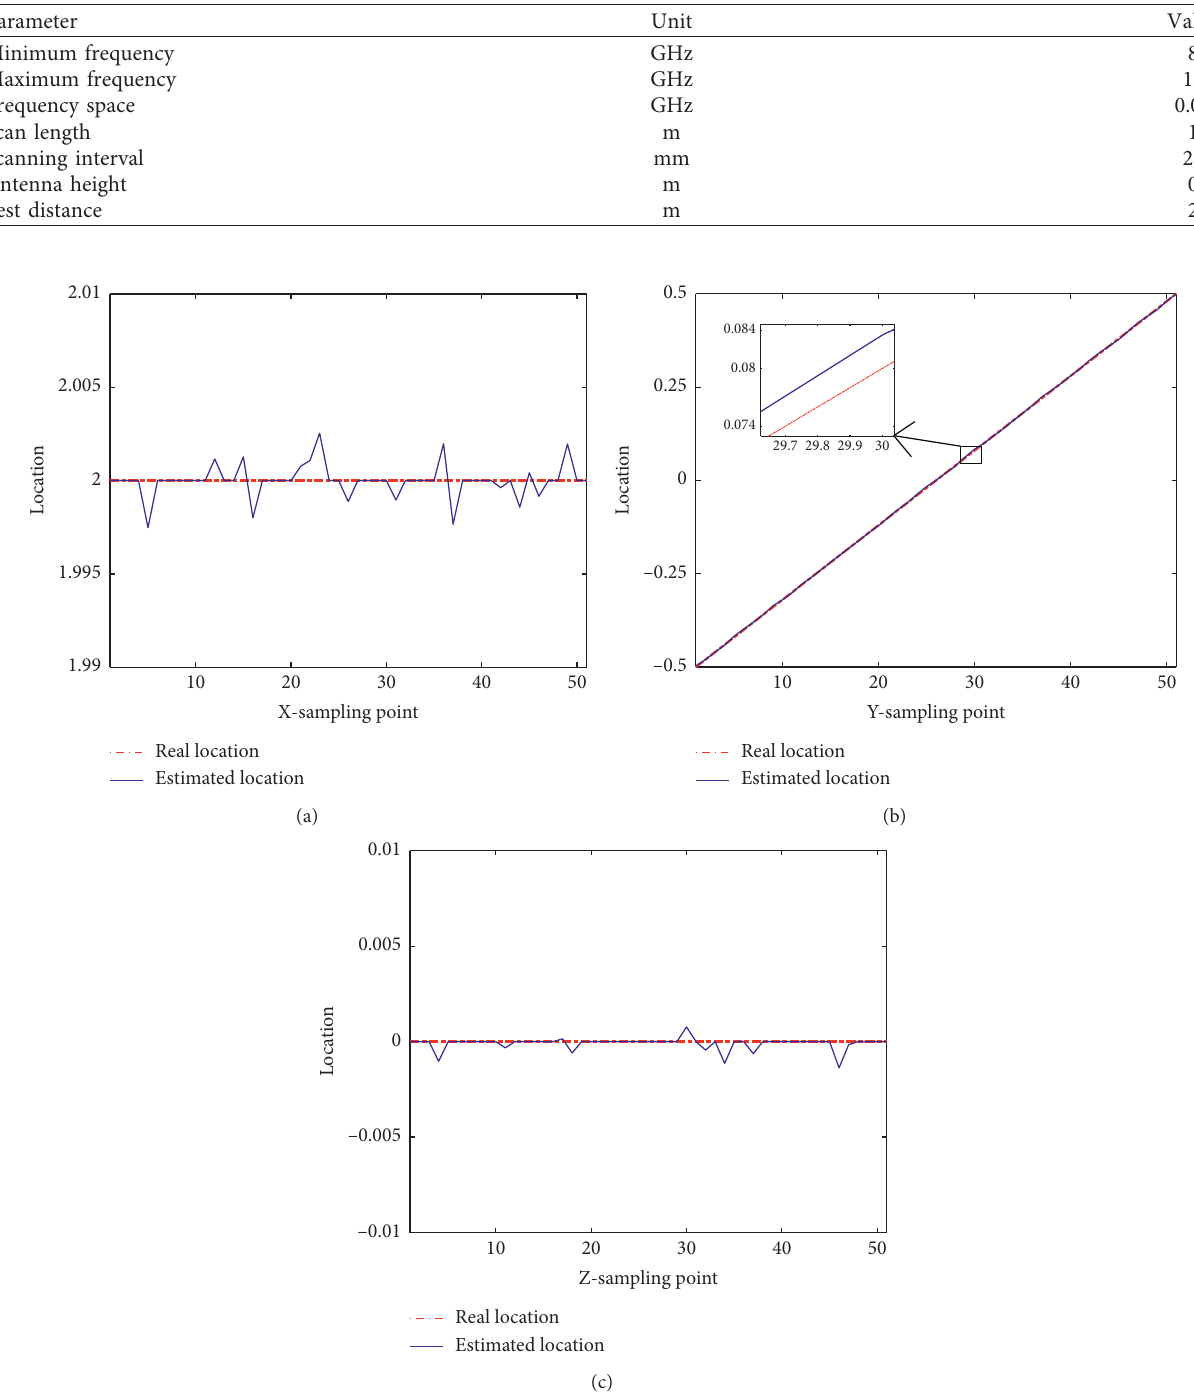
Table 2: Parameters of microwave anechoic chamber SAR simulation system.